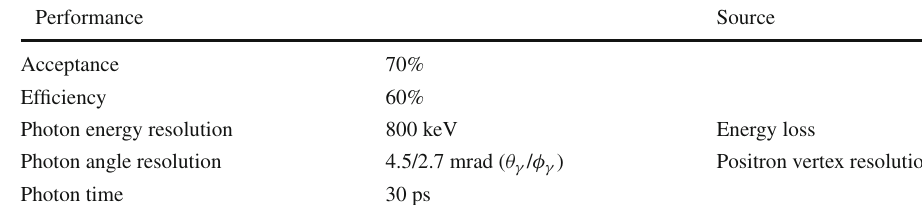
Table 5 Photon reconstruction performances of a baseline μ + → e + γ experiment with calorimetry